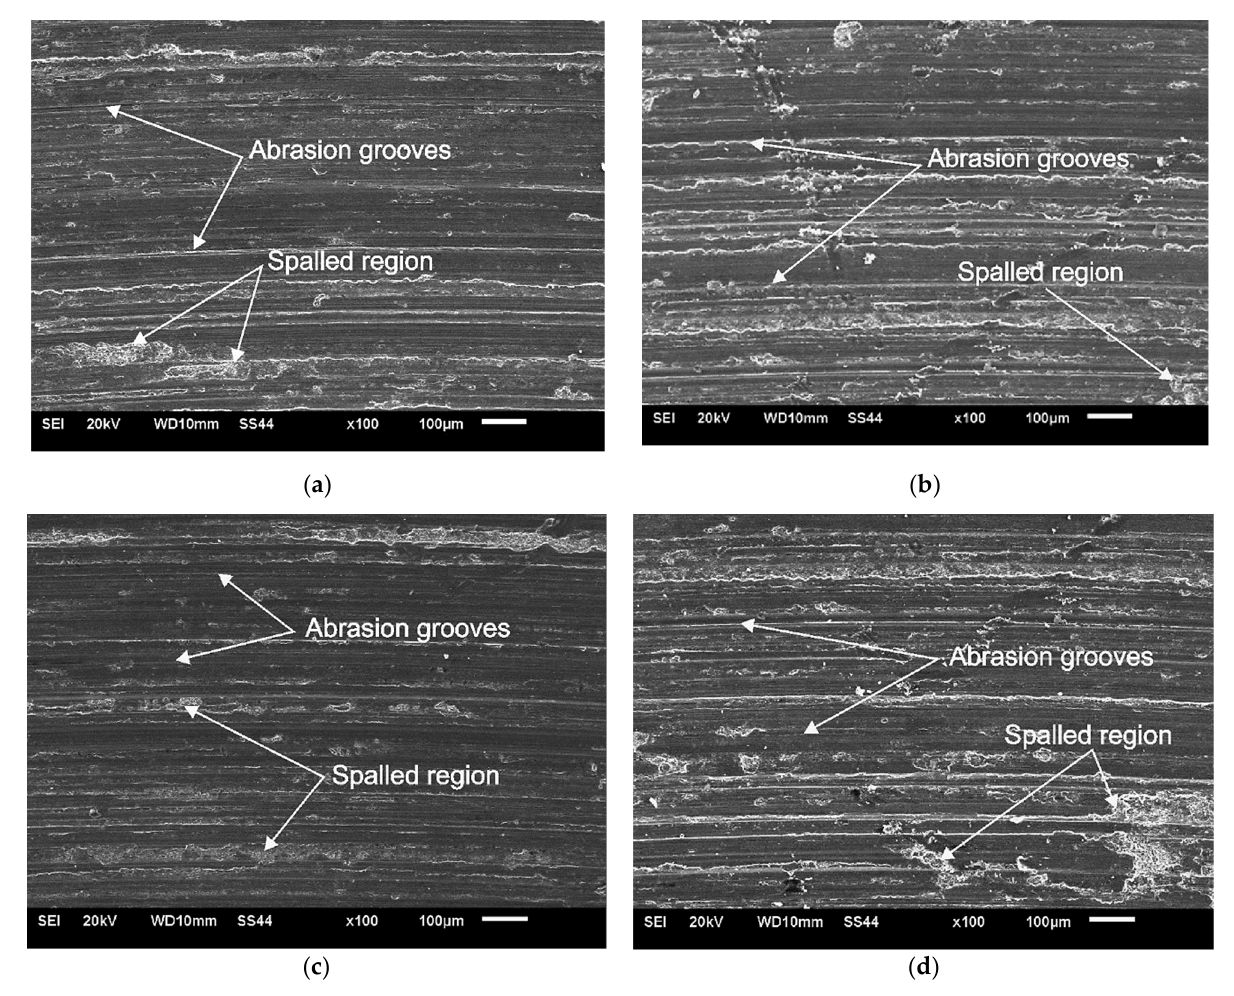
Figure 15. Worn surface morphologies of as-cast specimen ( a ), NC specimen ( b ), AC45 specimen ( c ), AC90 specimen ( d ). SEM.